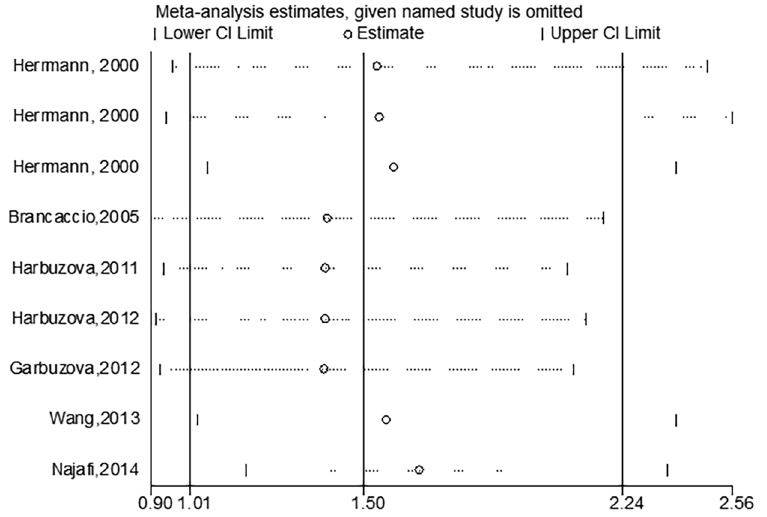
Figure 4. Sensitivity analysis of the rs1800801 polymorphism in recessive